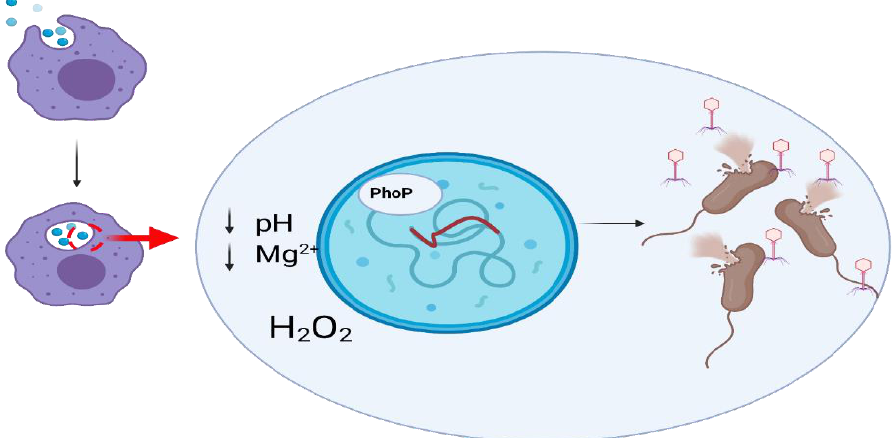
Figure 7. Interaction of lysogenic E. coli with macrophage. Recognition of pathogenic E. coli by macrophage results in phagocytosis. Inside the phagosome, specific conditions occur, such as low pH or low magnesium ion concentration. Hydrogen peroxide molecules are also present there. These conditions cause prophage induction through the action of the bacterial transcription regulator PhoP, leading to the lysis of E. coli cells and release of virions.